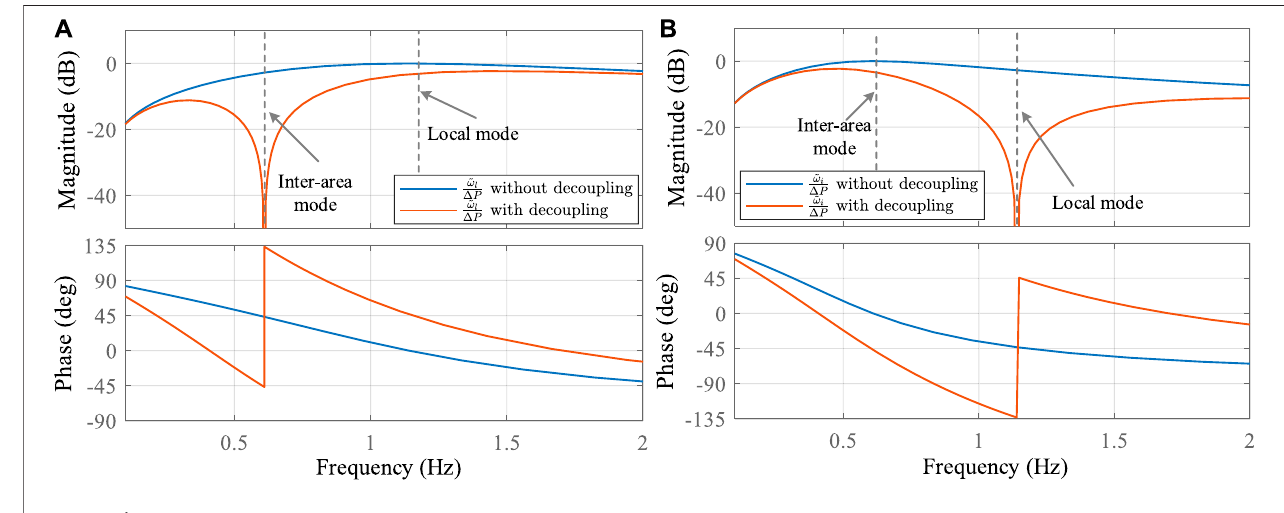
FIGURE 4 | Frequency response of decoupling network in Eqs. 8 , 9